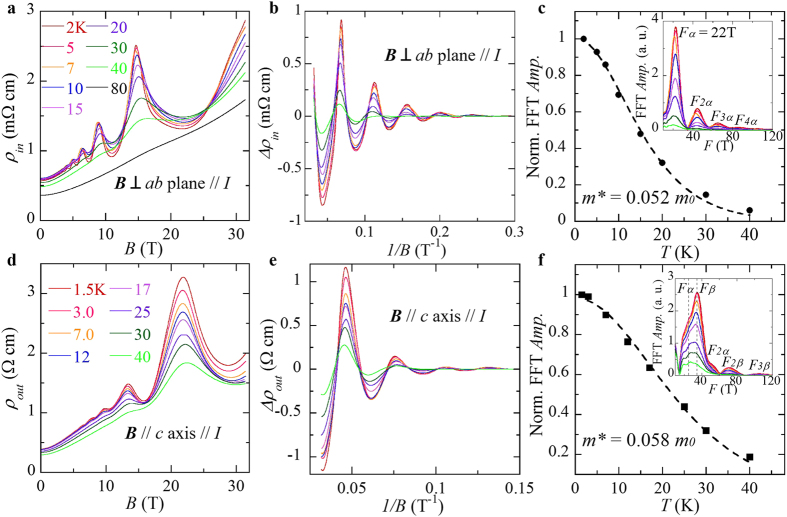
Quantum transport properties of BaMnSb2.(a) The in-plane resistivity, ρin, as a function of field up to 31T at different temperatures. (b) The oscillatory component of ρinvs. 1/B at different temperatures. (c) The temperature dependence of the normalized FFT amplitude. The dashed line curve is the fit to the Lifshitz-Kosevich (LK) formula from 2 to 40 K. Inset: FFT spectra of Δρin(B) at different temperatures (the FFT was done in the field range of 3T–31T). (d) The out-of-plane resistivity, ρout. as a function of field at different temperatures. (e) The oscillatory component of ρout vs. 1/B. (f) The temperature dependence of the normalized FFT amplitude. The dashed line is the fit to the LK formula. Inset: FFT spectra of Δρout(B) at different temperatures (the FFT was done in the field range of 5T–31T).